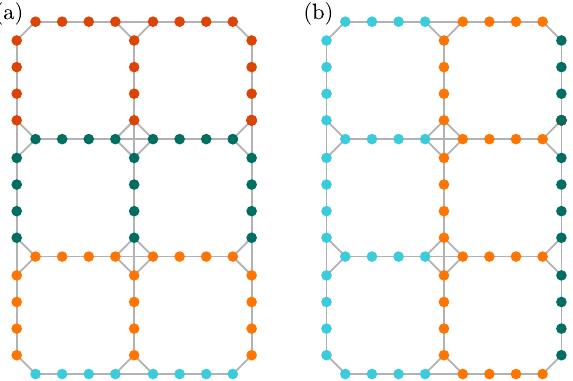
Fig. 10 Labeling of an alternative sparsely-connected device. It is constructed from the linear segments and four-way junctions shown in Fig. 1a, b respectively. The generalized a rows and b columns are shown. Qubits are represented by dots and lines indicate between which qubits a two-qubit gate can be performed. Qubits of the same color are in the same row or column. For this device, the rows and columns have branches, which may increase the overhead of the Case II